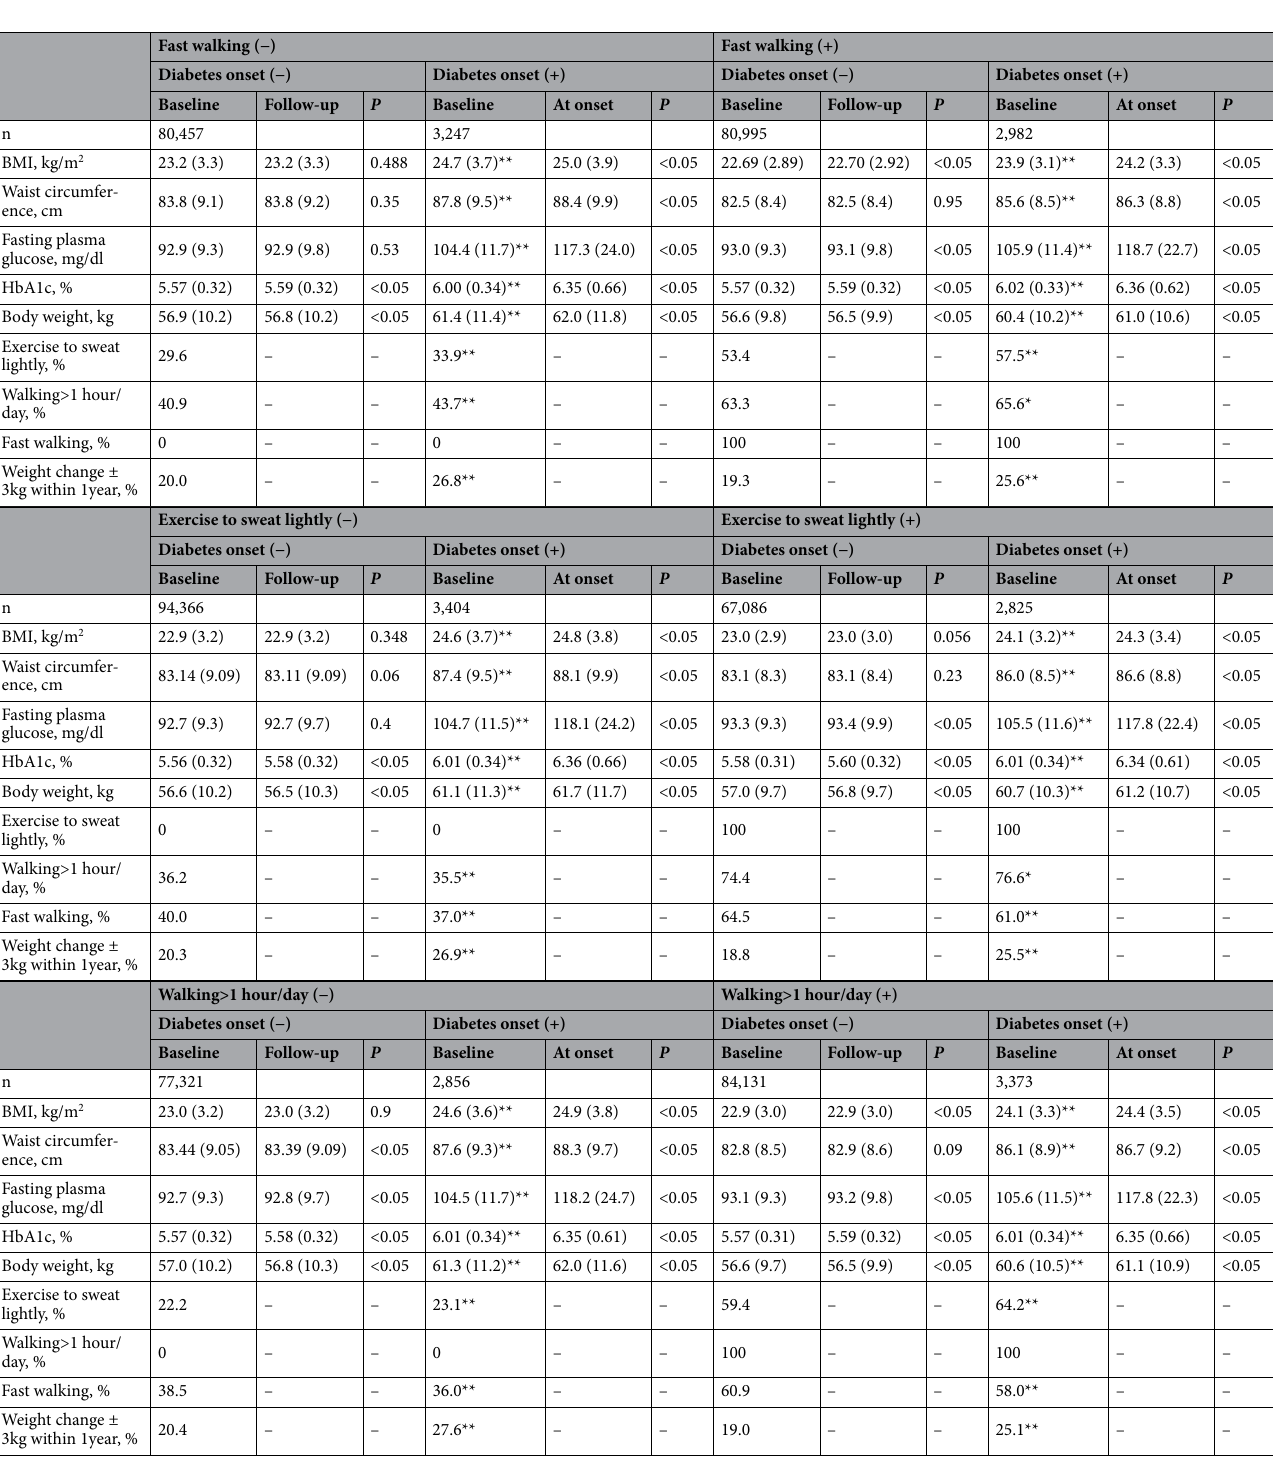
Table 4. Characteristics of three physical activity measures subgroups at baseline and follow-up or onset of